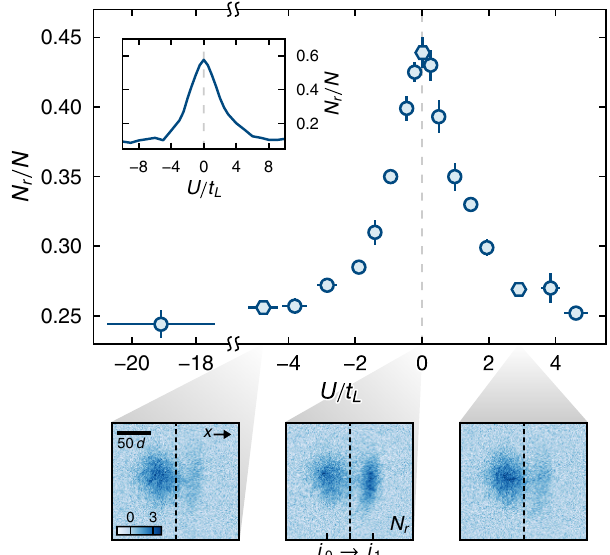
FIG. 3. Constrained early-time dynamics in the interacting =N transported heavy-light mixture. Fraction of light atoms N r to the right half of the system (blue markers) for variable heavy- 0 . 104 ð 7 Þ , =t light interaction strength U , fixed hopping ratio t H L ¼ 1 . 7 ð 1 Þ × 10 − 2 . Each point is the average and confinement κ =t L ¼ of 3 – 4 measurements, and error bars (partly smaller than the =N and the marker size) denote the standard error of the mean of N r uncertainty of U=t . The bottom panels show raw atomic column L − 4 . 8 ð 4 Þ , 0.02(4), and 2.9(2) (from left to densities for U=t L ¼ right, hexagonal markers), with the dashed lines indicating the boundary that determines the atom count N in the right half of the r system. The inset of the main panel shows the numerical matrix- product-state simulations of a single tube with the Hubbard parameters and confinement strength of the experiment, and N 5 atoms of each sim ¼